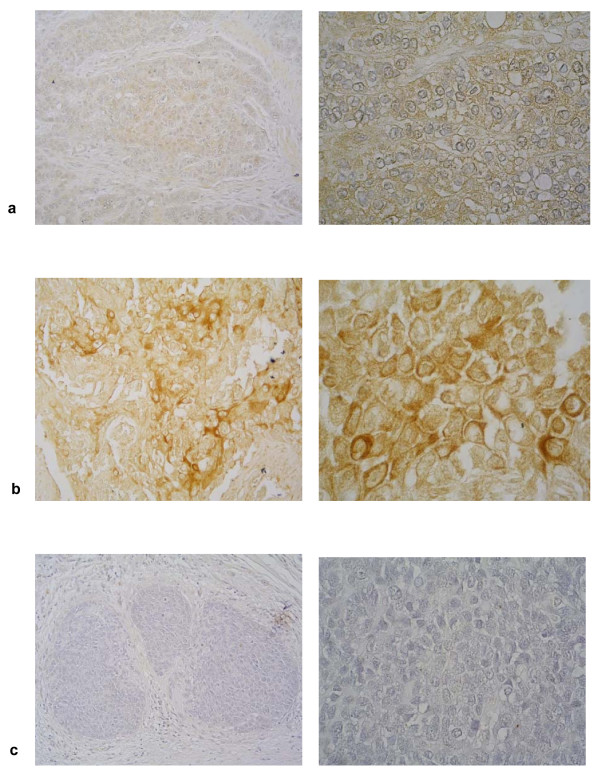
a-c. CXCR4-expression in squamous cell carcinoma with weak (CXCR4w) (a) and strong (CXCR4s) (b) staining intensity compared to negative control (c).